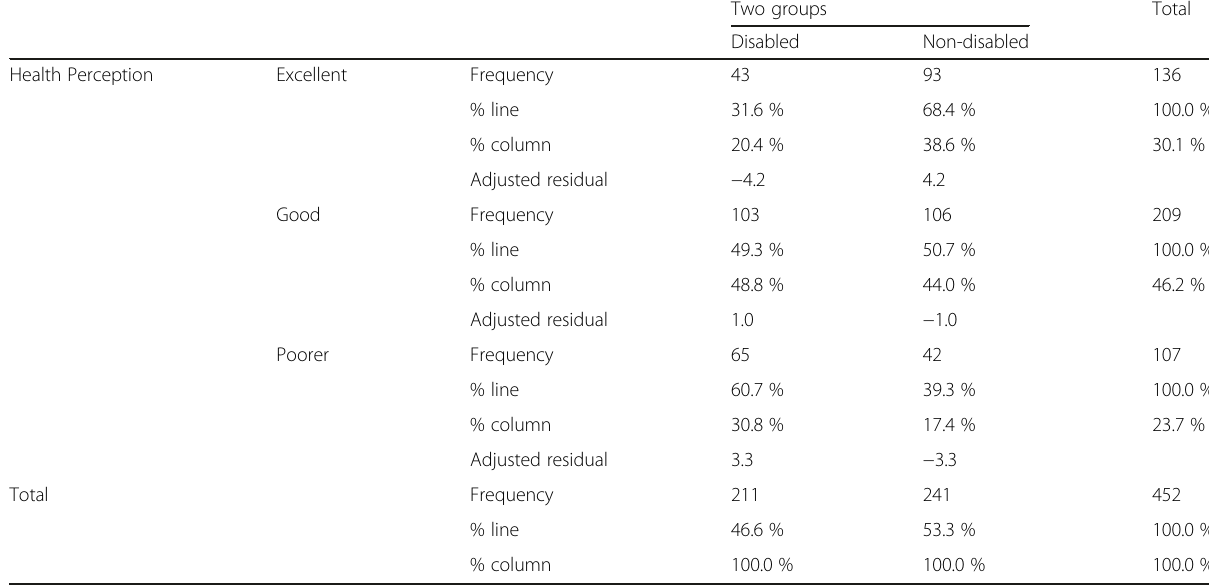
Table 3 Comparison of health perception between disabled and non-disabled groups